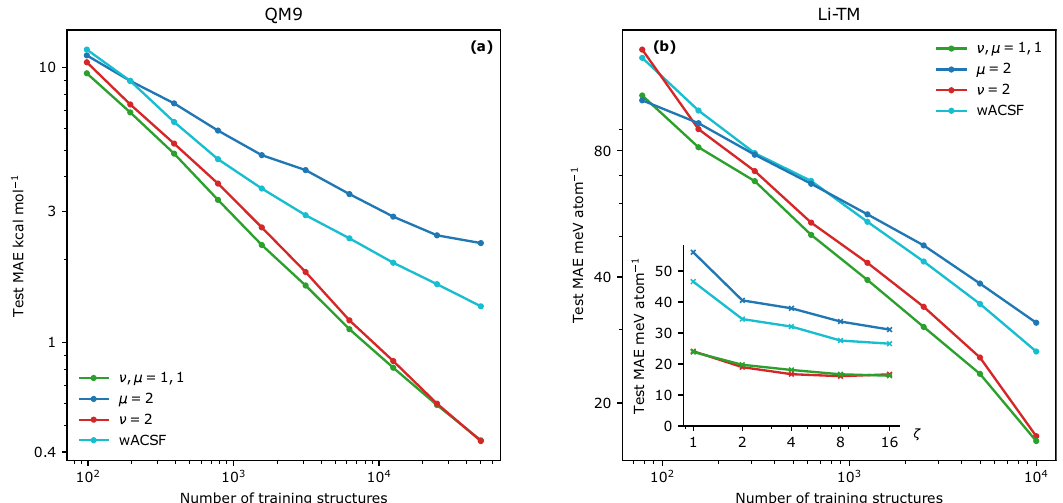
Fig. 10 Learning curves for ACSF energy models. Energy errors for KRR models with ACSF's as the atomic descriptors for the QM9 ( ζ = 2) and Li-TM ( ζ = 16 shown in main panel) datasets. The inset on the right shows how the error changed with ζ for a training set with 10 4 con fi acids from ref. 52 containing a total of 11 different elements. The dataset covers a total of 280 molecular systems - product of 20 proteingenic amino acids with 2 different backbone types (N- terminally acetylated or C-terminally amino-methylated) and 7 different cation additions (None, Ca 2 + , Ba 2 + , Sr 2 + , Cd 2 + , Pb 2 + or